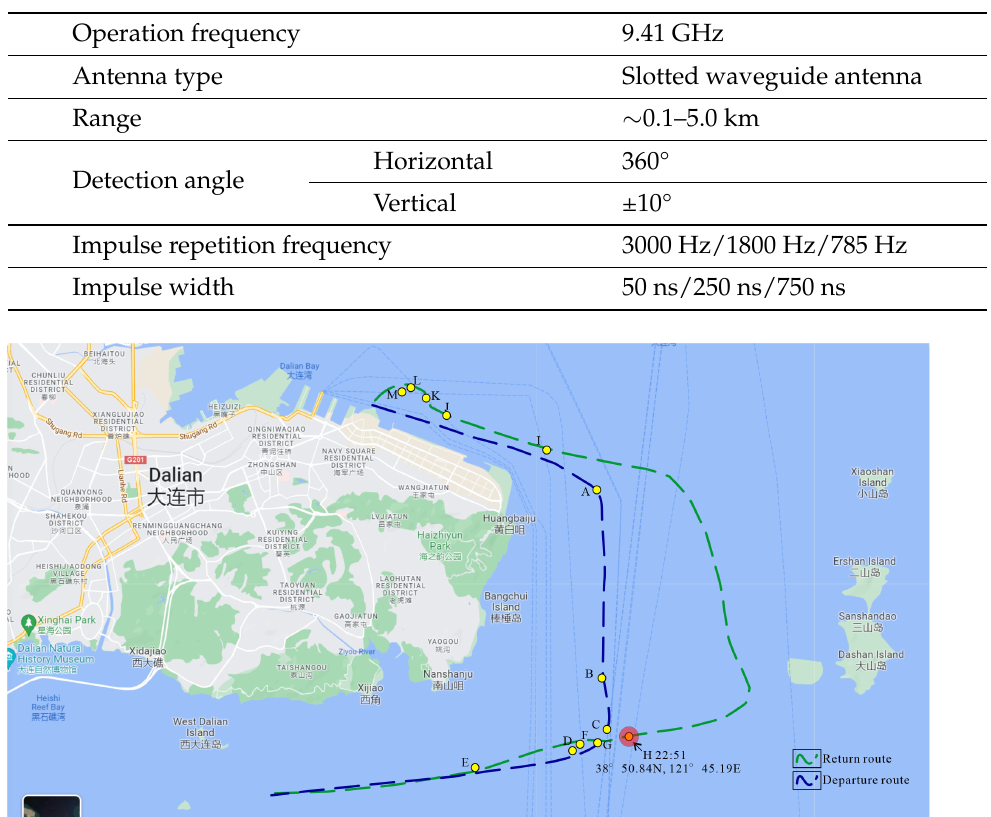
Table 1. Main parameters of the marine radar.